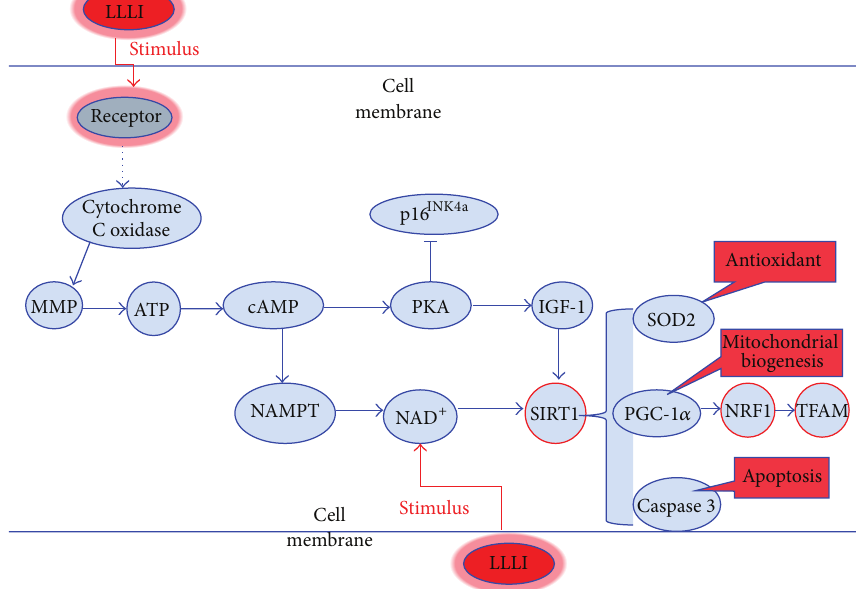
Figure 3: Schematic depiction of the cellular signaling pathways triggered by LLLI. After photons may be absorbed by chromophores in the cell membrane, mitochondria cytochrome C oxidase, MMP, ATP, and cAMP may be increased, but signaling pathways such as PKA/IGF-1 may be also increased, contributing to increased NAMPT/SIRT1 pathway and inhibited expression of p 16 INK 4 a